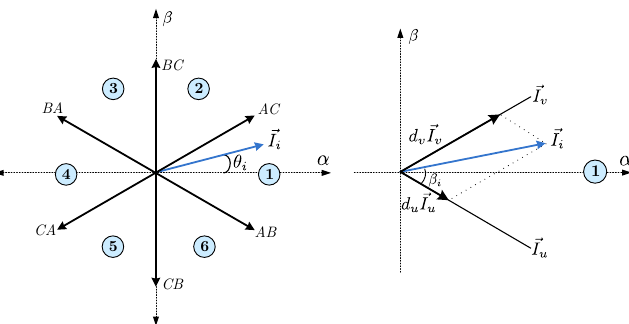
Figure 8. CSR SVM to synthesize the current of the rectifier stage.